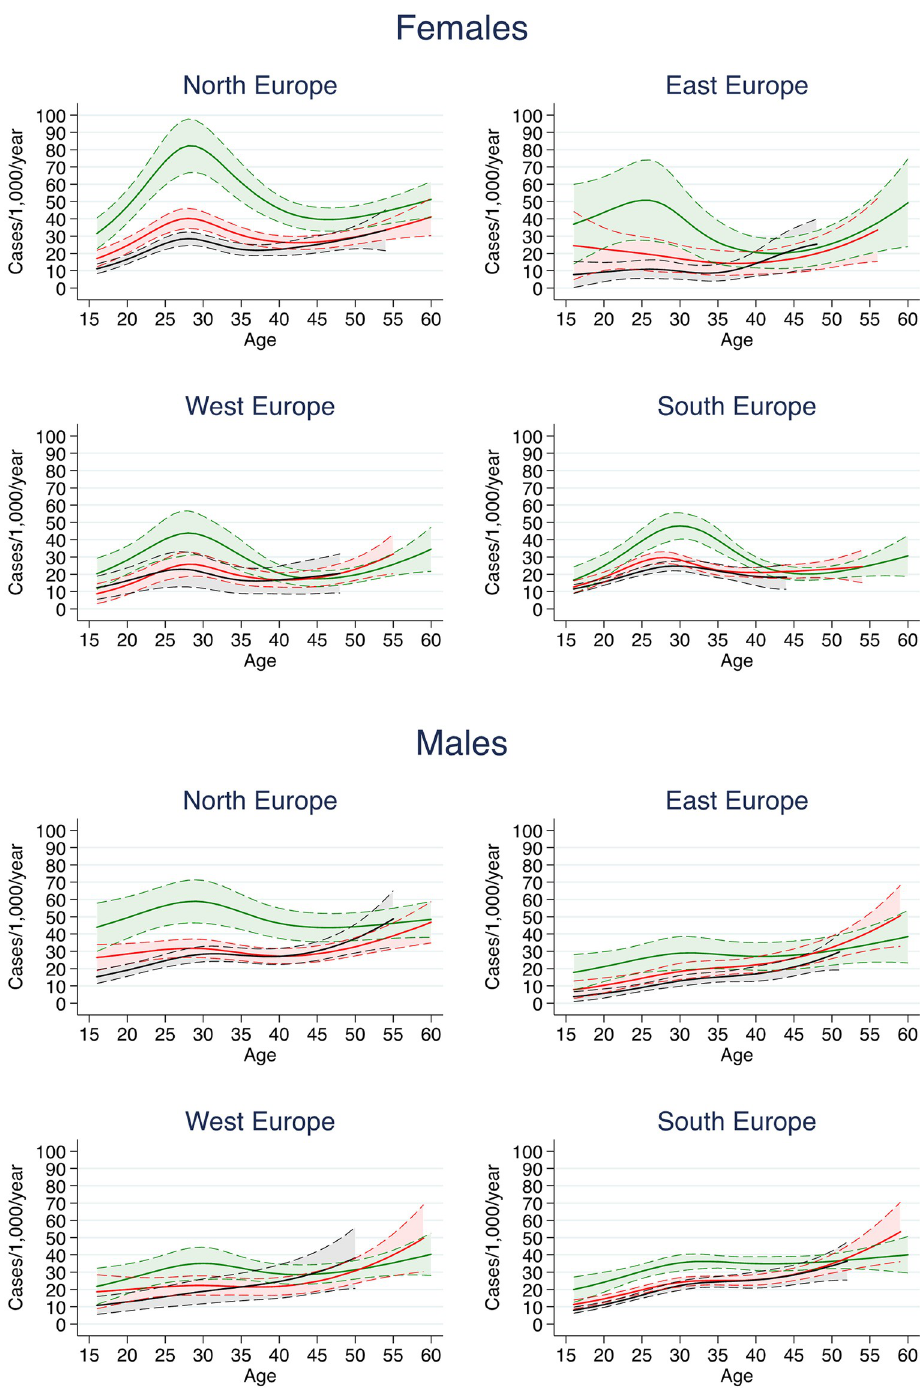
Fig 1. Estimated trends in smoking cessation rates (per 1,000/year) with 95% confidence intervals in females and males, by region. Trends were stratified by period: black lines refer to 1980–1989; red lines refer to 1990–1999, and green lines refer to